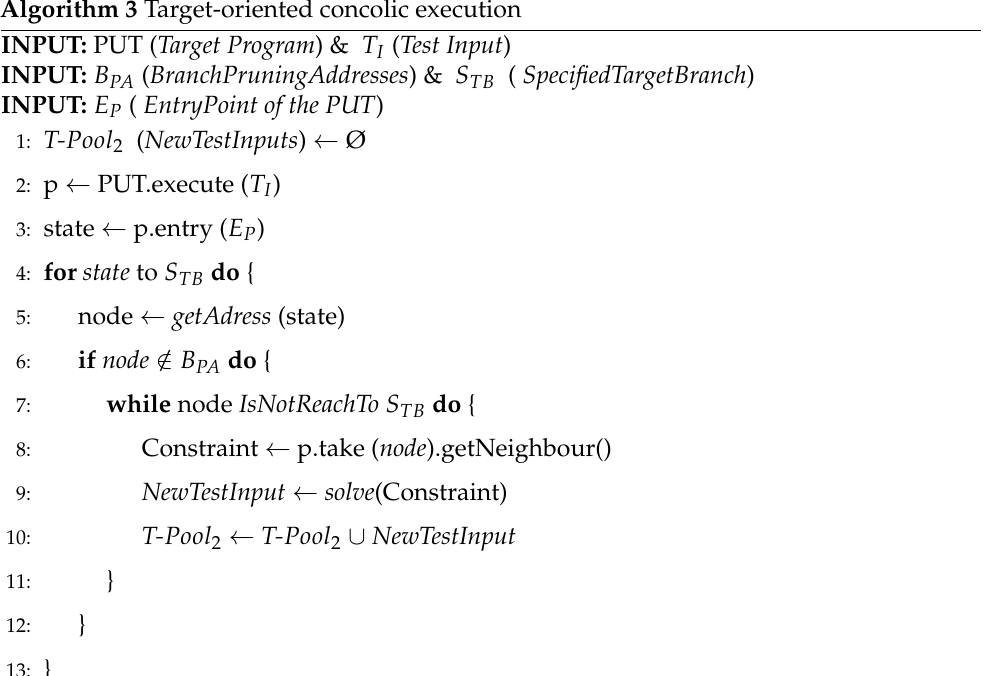
Algorithm 3 Target-oriented concolic